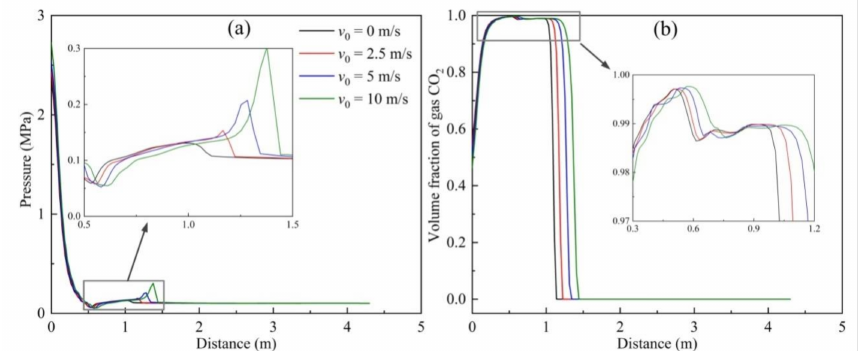
Figure 10. Effects of flow velocity on ( a ) total pressure and ( b ) volume fraction of gas CO 2 out of rupture opening (location of 0 m is the rupture opening) at a flow time of 13 ms.